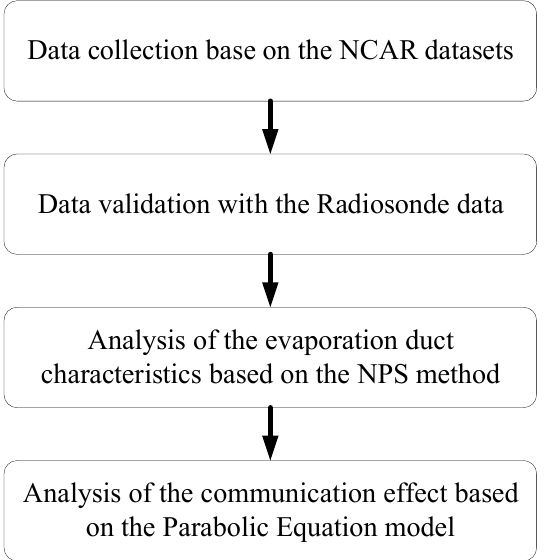
Figure 1. Methodology of communication effects under evaporation ducts.